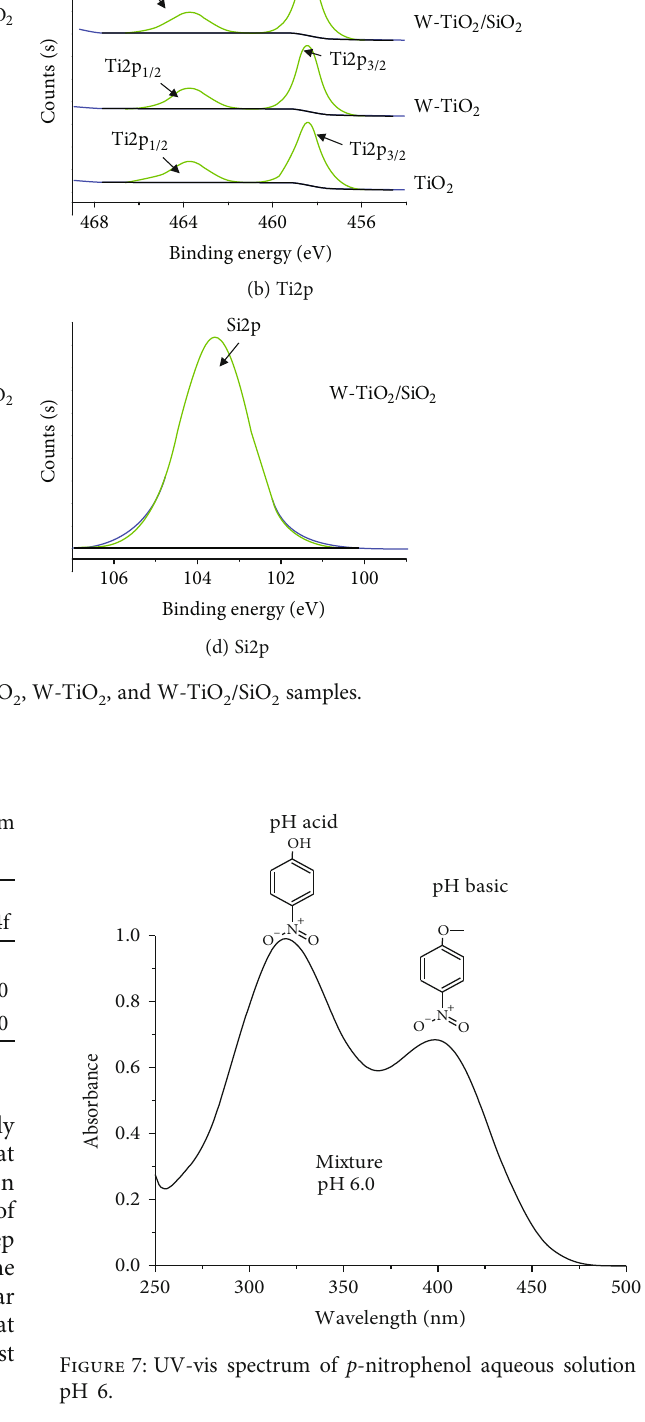
Figure 7: UV-vis spectrum of p -nitrophenol aqueous solution at pH